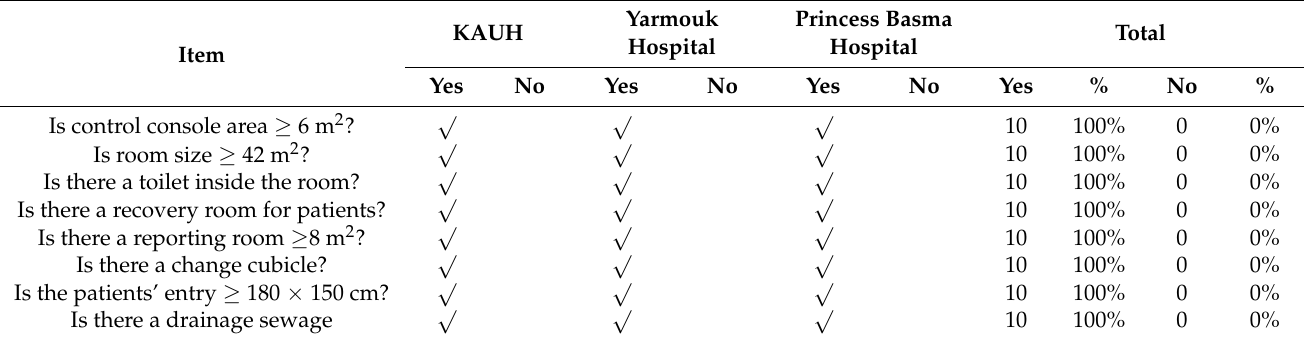
Table 6. Checklist for structure of CT at public hospitals. (No. of samples =